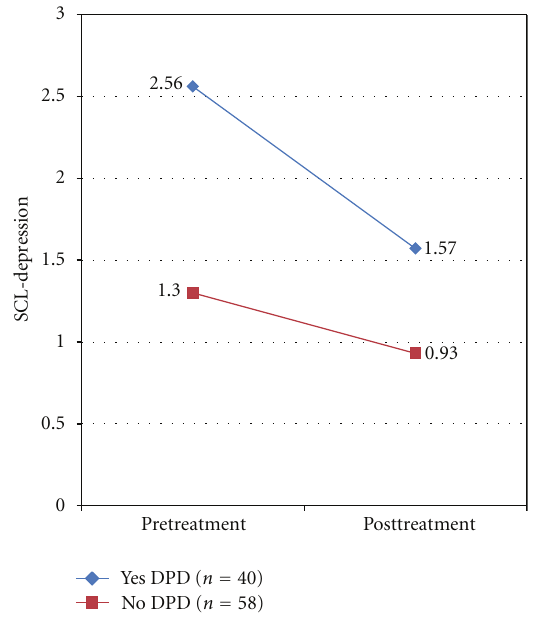
Figure 1: Changes in mean depression scores from pre- to posttreatment between groups (DP yes, top line; DP no, bottom line). Note. SCL-Depression: symptom checklist-90 depression